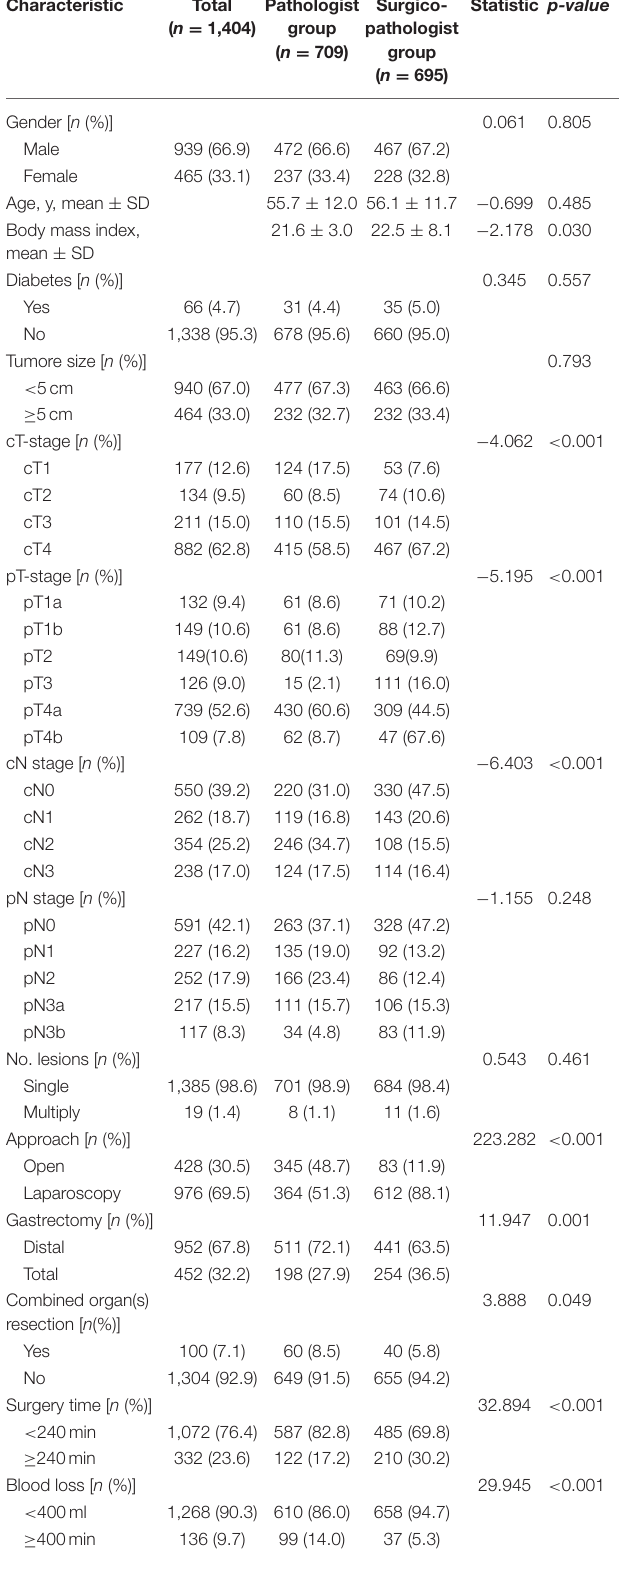
and distal gastrectomy [511(72.1%) vs. 441(63.5%), p < 0.001], TABLE 1 | Clinicopathologic characteristics of the two groups of patients. with less surgery time [surgery time ≥ 240 min: 122(17.2%) Characteristic Total Pathologist Surgico- Statistic p-value ( n = 1,404) group pathologist ( n = 709) group ( n = 695)